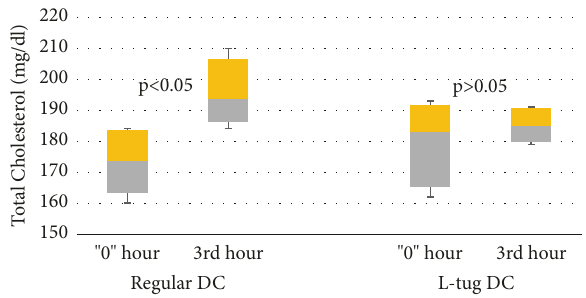
Figure 3: Changes in serum total cholesterol concentration after ingestion of regular and L-tug DC. (“p” reflects the statistical difference between initial and final